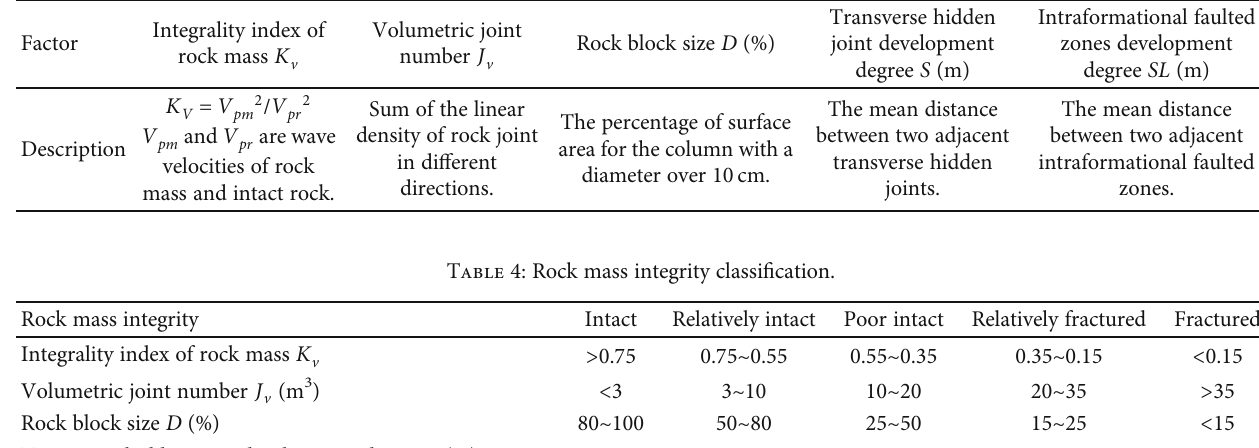
Table 3: The main factors in the classi fi cation of columnar jointed rock mass.